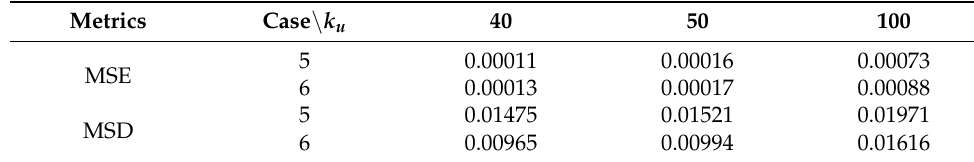
Table 2. MSE and MSD with different k u s for cases 5 and 6.